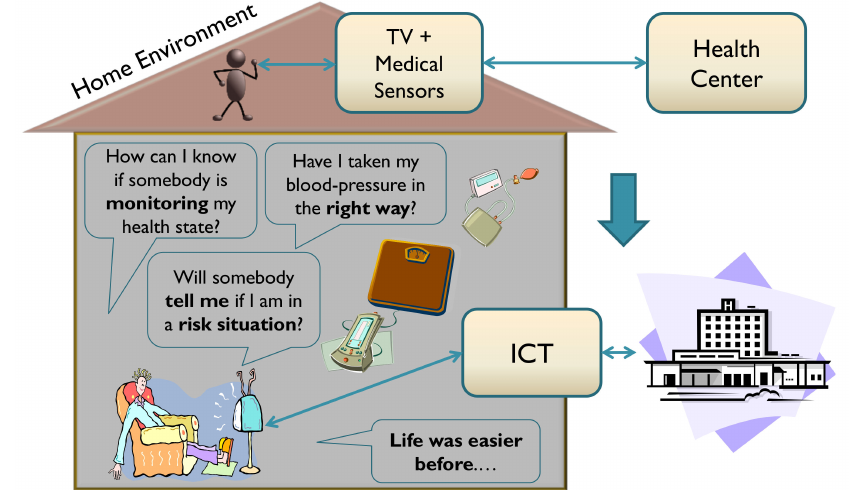
Figure 1. Generic representation of some user fears related to inclusion and deployment of telehealth services in the digital home